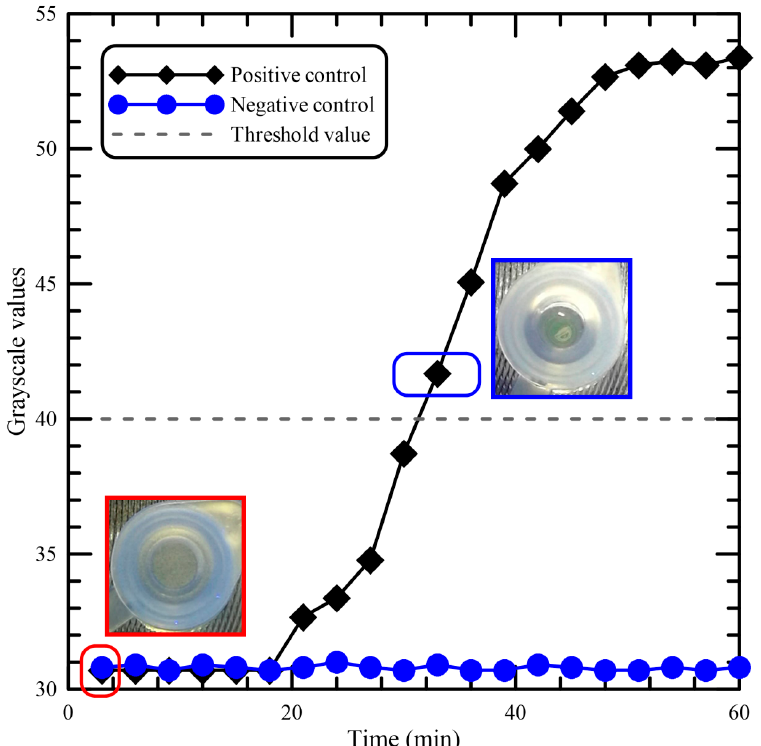
Figure 5. The grayscale values of the DNA sample under UV light. The real-time kinetics of the LAMP reaction with or without DNA samples at 62 °C are identified by monitoring fluorescence intensities from the tube. To evaluate the performance of the portable device for the quantification of DNA mixtures, several serially diluted DNA samples were utilized. The LAMP assays using fluorescence detection reagent were compared with regard to the detection of 10-fold se- rially diluted DNA. The amplification curves for DNA samples are expressed in Figure 6 and were analyzed for the sensitivity of the device. The times to reach the threshold value of 40 at the concentrations of 10 − 1 , 10 − 2 , 10 − 3 , and 10 − 4 ng/ μ L were about 30, 37, 43, and 46 min, respectively. At the concentration of 10 − 5 ng/ μ L, the fluorescence signals were al- most similar to the signals emitted from the negative sample. In terms of the analytical sensitivity of LAMP in 60 min, a lower limit of detection of the concentration of 10 − 4 ng/ μ L was achieved.